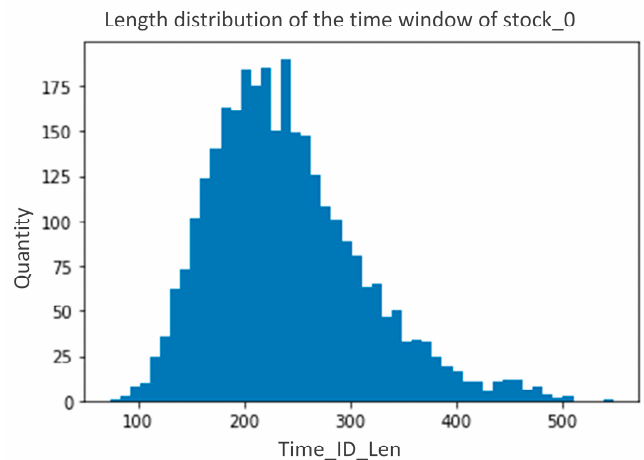
Figure 14. Data volume distribution for time windows.